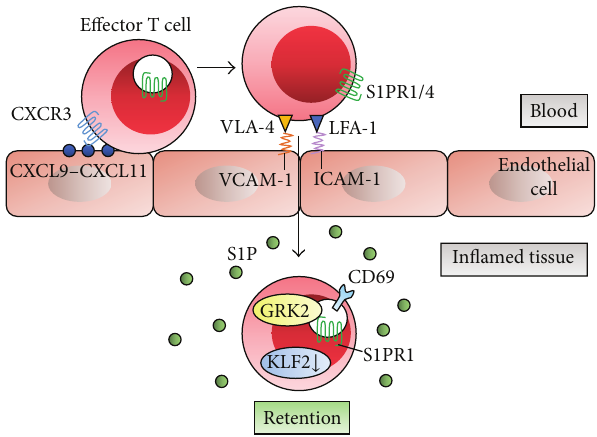
Figure 2: S1P-S1PR1 axis and lymphocyte retention in inflamed tis- sue. Surface expression of S1PR1 and S1PR4 on T cells is induced by chemokines CXCL9 − CXCL11 presented on the endothelial surface and results in T cell migration into inflamed tissue. This is mediated